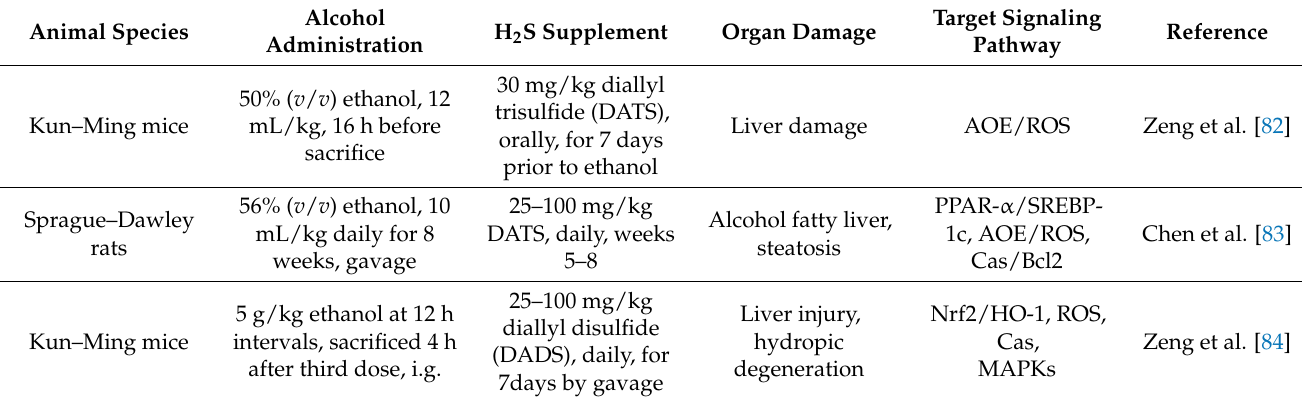
Table 2. Animal models used for analyzing H 2 S signaling and alcohol-induced